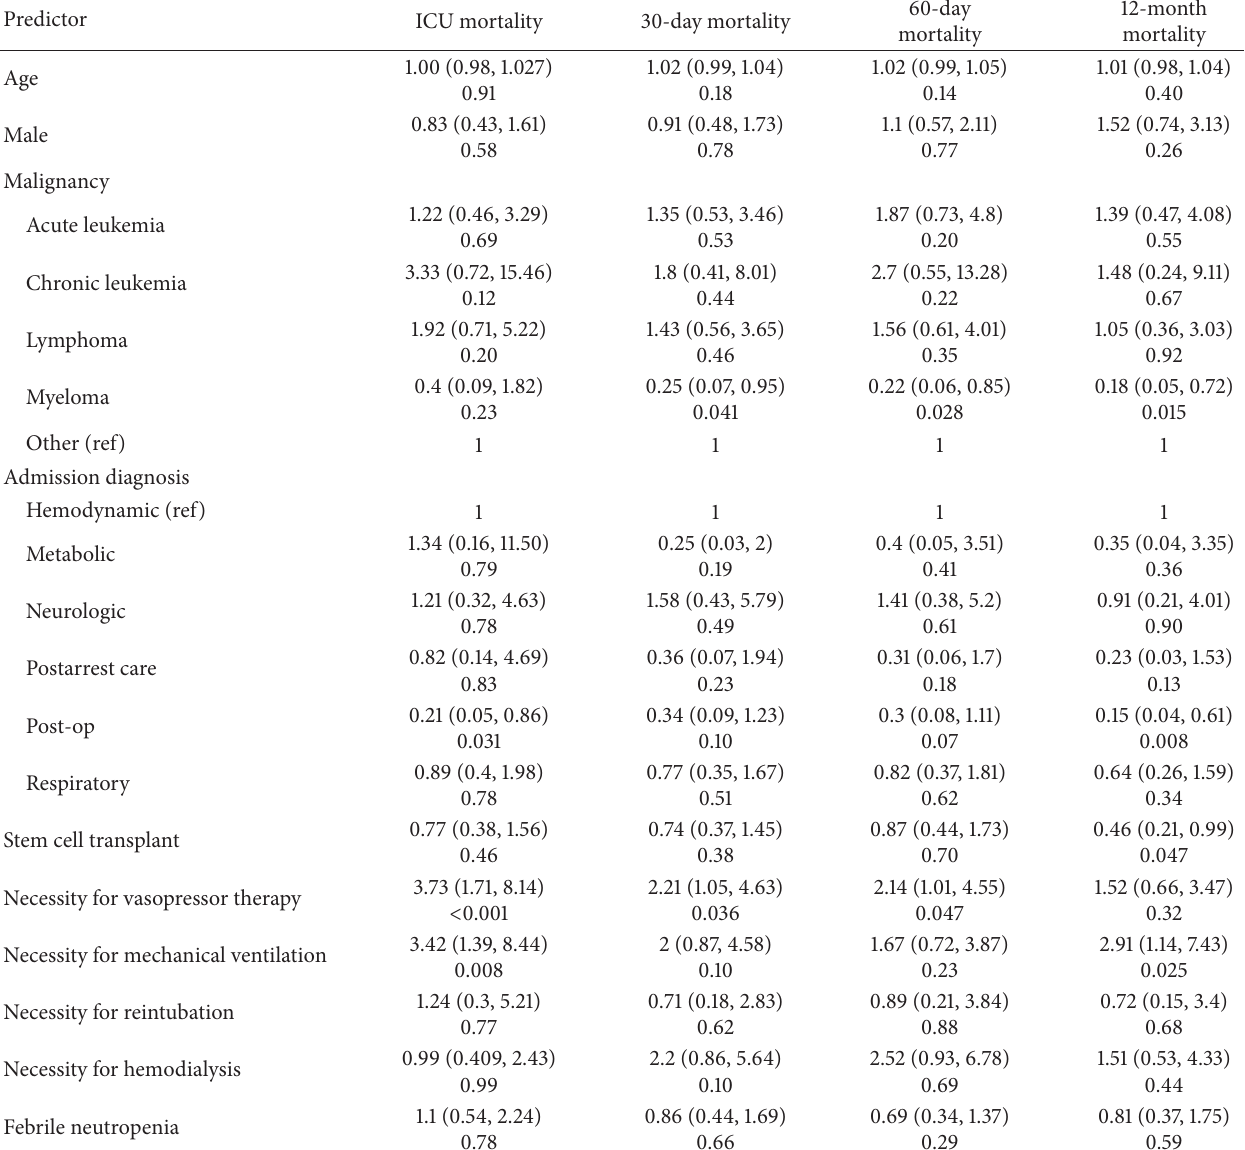
Table 5: Logistic regression predicting ICU mortality and long-term